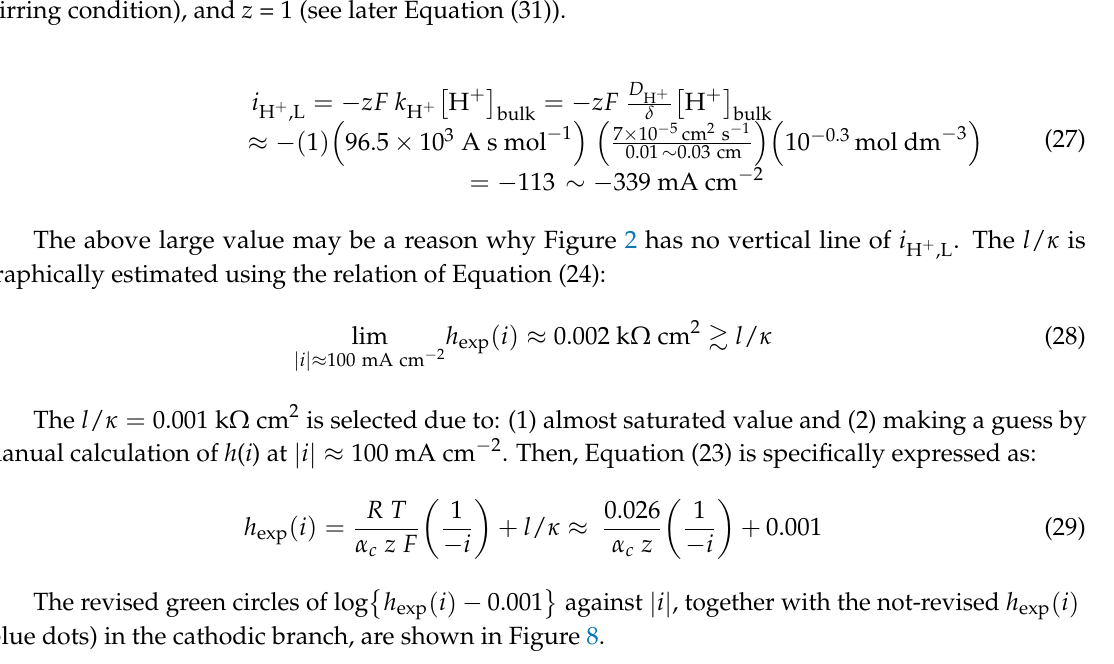
Figure 9. The relation between (cid:2009) (cid:2913) (cid:1878) and |(cid:1861)| is plotted using Equation (30). The value of (cid:2009) (cid:3030) (cid:1878) was (cid:3406) 0.7 by the least ‐ squares approximation method.